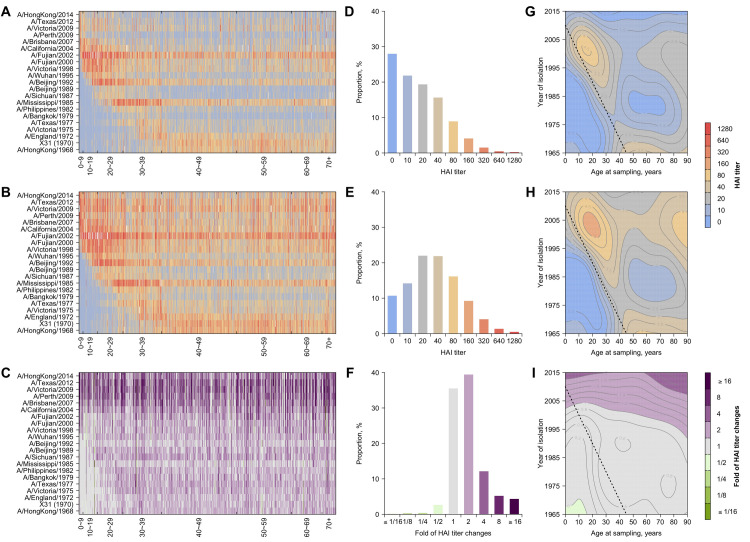
HAI titers and differences in HAI titers between two visits against historical H3N2 strains.(A) and (B): HAI titers against H3N2 strains from serum collected from baseline and follow-up visit, respectively. Participants are sorted by age at baseline sampling. (C): Fold of changes of HAI titers between two visits. Cell of row i and column j represents HAI titer or differences of HAI between two visits to strain i for person j. (D-F): Distribution of HAI titers from serum collected from baseline (D), follow-up visit (E), and fold of changes between two visits (F), respectively. Distributions were plotted after grouping titers across all participants and all tested H3N2 strains. (G) Variations of HAI titers at baseline with ages of participants and the year of isolation of tested strains. Dashed lines represent birth years of the participants (same for panel H and I). (H) Variations of HAI titers at follow-up with ages of participants and the year of isolation of tested strains. (I) Variation of changes in HAI titers between the two visits with ages of participants and the year of isolation of tested strains.